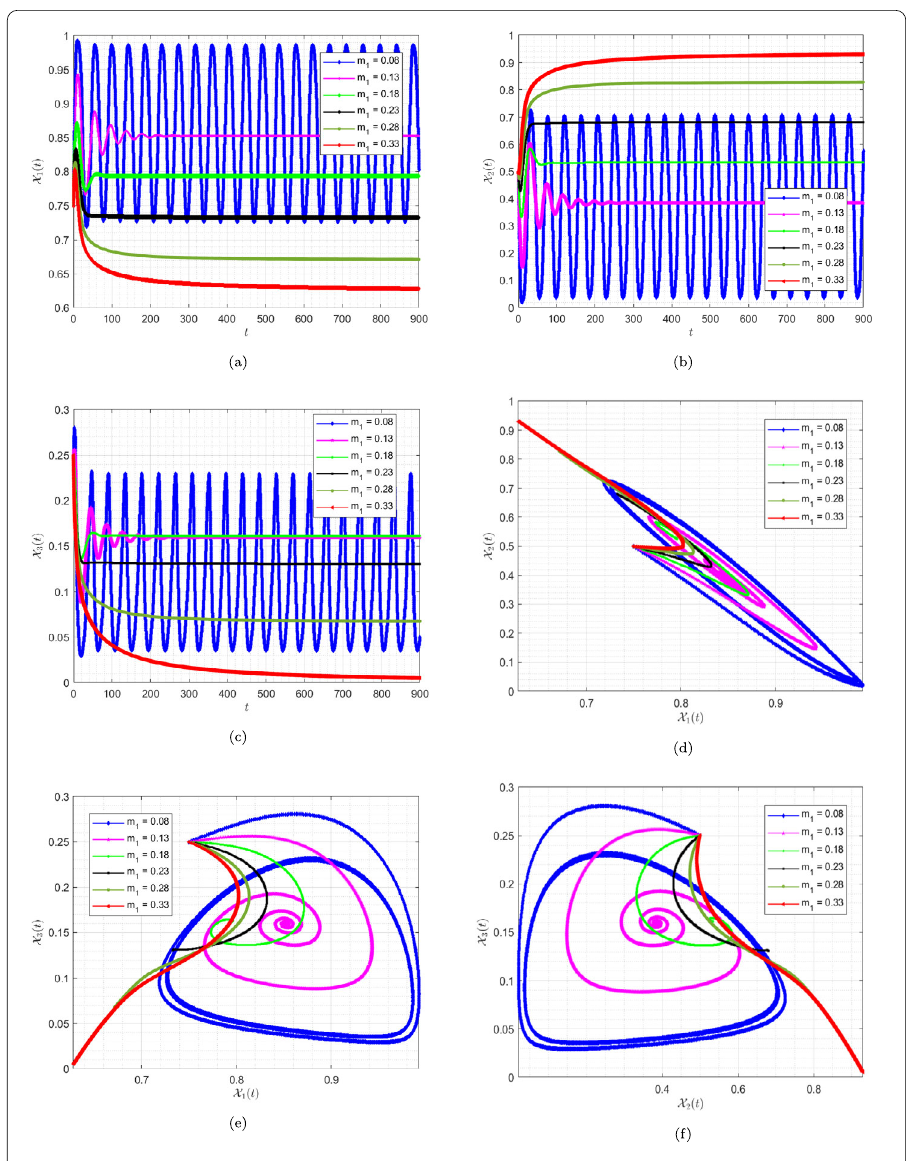
Figure 9 Dynamics for system (19) by taking different values of parameter m 1